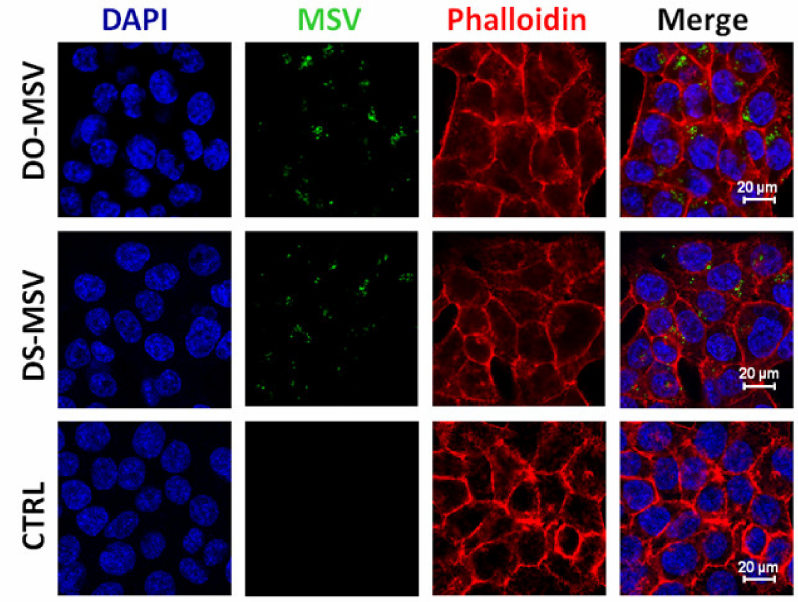
Figure 8. Confocal microscopy images of cells treated with MSV-oxaliplatin-loaded liposomes. HCT-116 cells were incubated for 24 h with 1 × 10 4 particles / µ L medium, 100 particles / cell. Untreated cells served as control